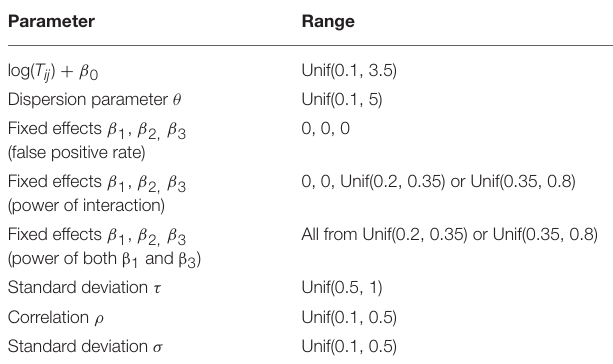
TABLE 2 | Parameter ranges in simulation